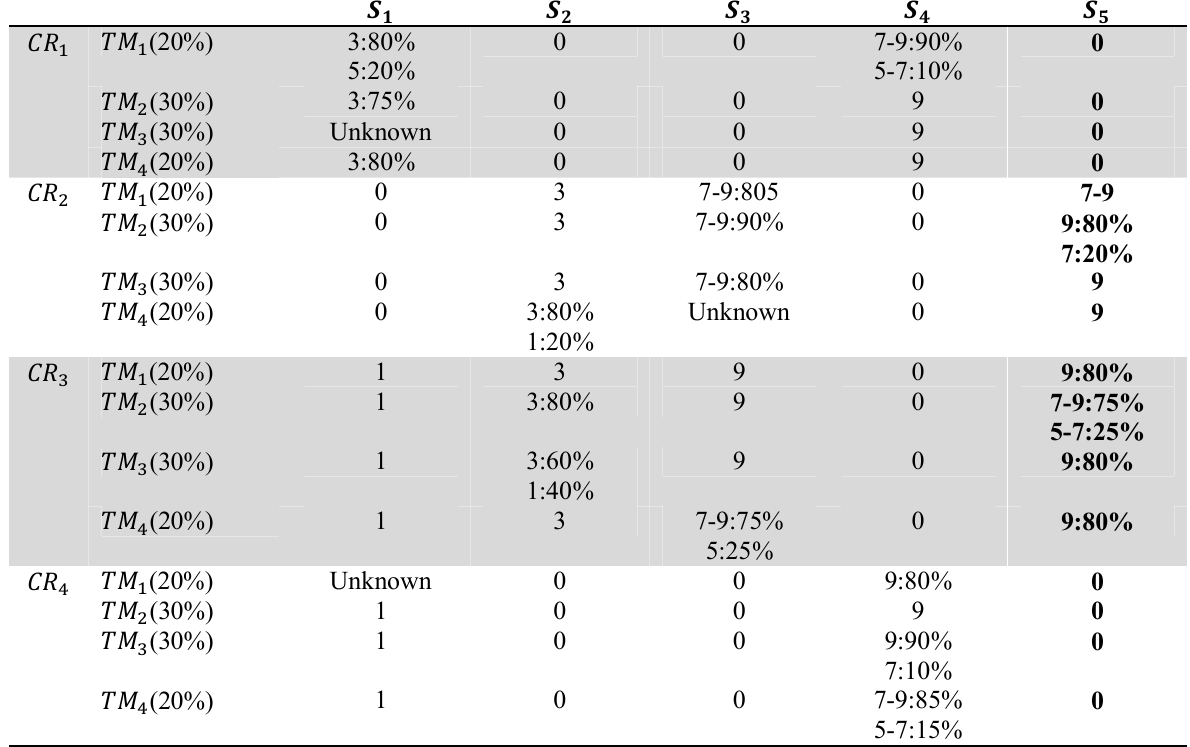
Assessment relationship between the Rumelt criteria and five strategies of